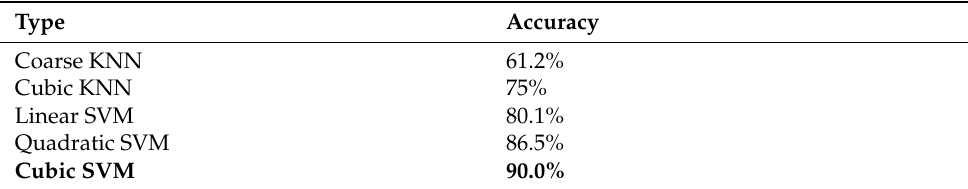
Table 4. KNN and SVM classification accuracy results.